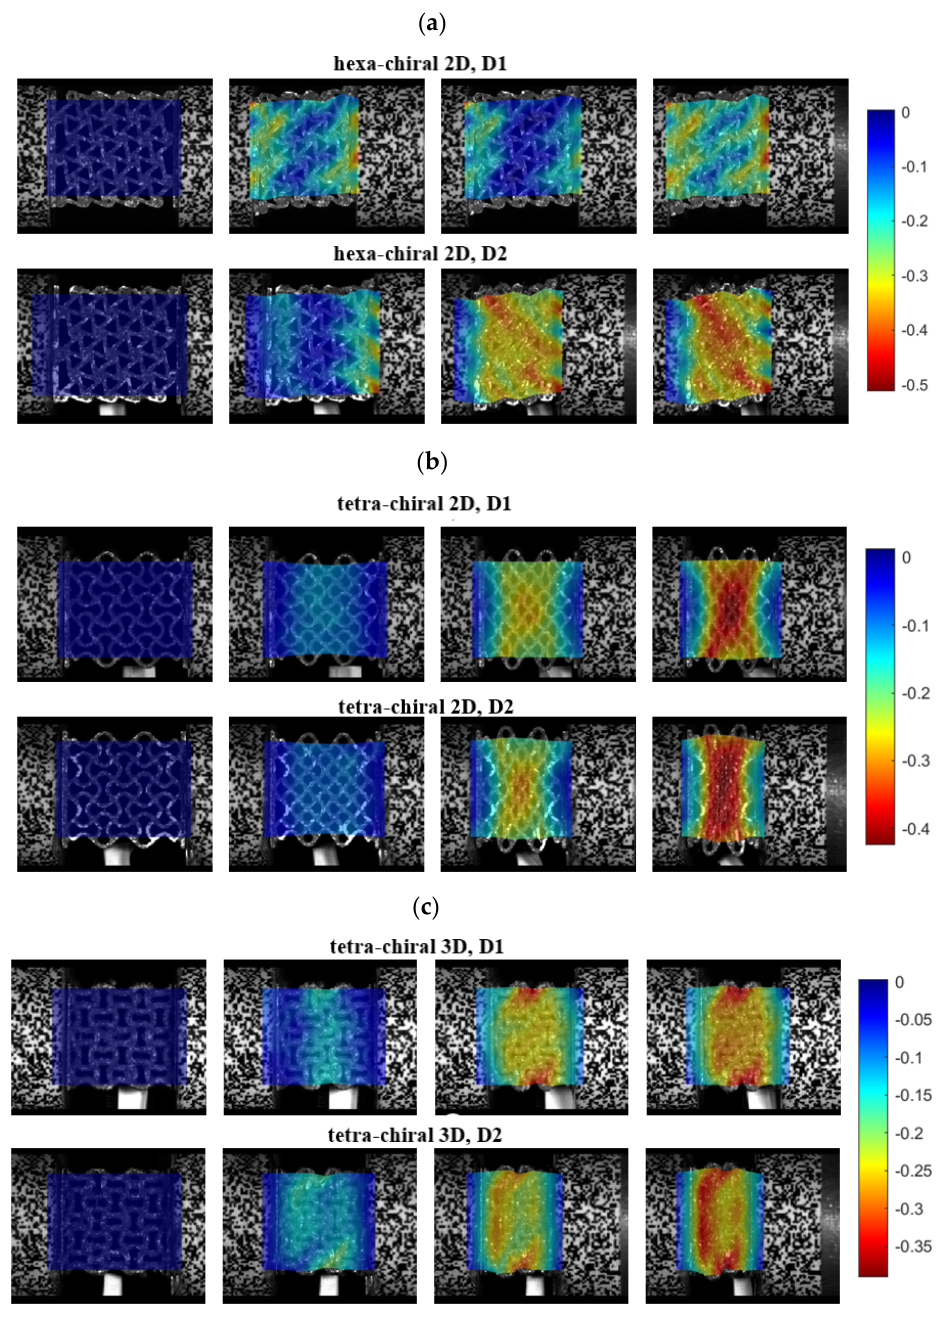
Figure 7. Evolution of full-field longitudinal strain of ( a ) hexa-chiral 2D, ( b ) tetra-chiral 2D, and ( c ) tetra-chiral 3D structure during impact testing at lower (D1) and higher (D2) impact velocity.